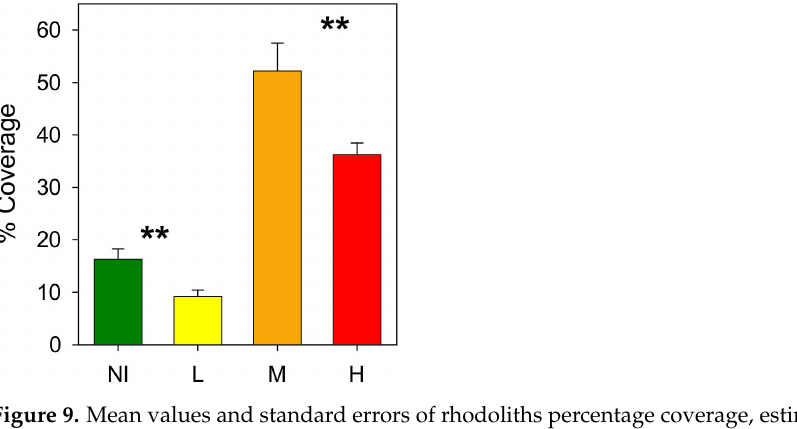
Figure 9. Mean values and standard errors of rhodoliths percentage coverage, estimated from visual transects with the TASIFE photogrammetric sledge in the four areas considered: Non-impacted (NI), Low effort history (L), Medium effort history (M), and High effort (H). p -values of the Student’s t -test to test for differences between areas are presented. * p < 0.05; ** p < 0.01; *** p <